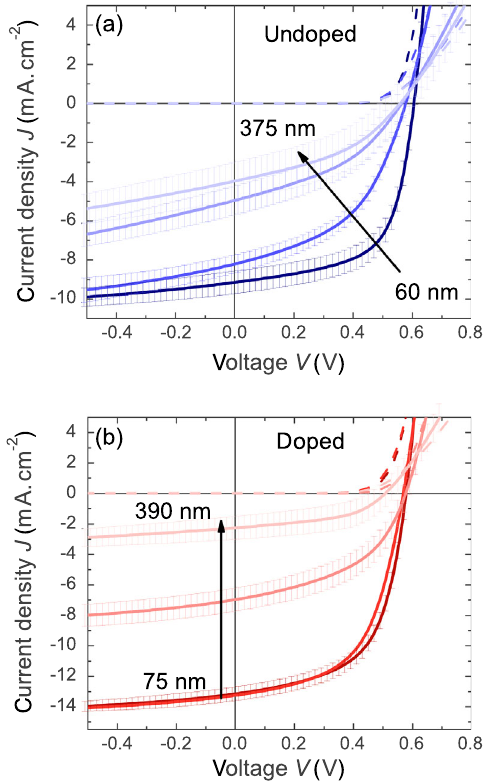
FIG. 3. Experimental AM1.5 (solid lines) and dark (dashed lines) J - V curves at increasing thicknesses for the two batches with different doping levels (a) DPP-TT-T u − PC 71 BM ( N A ≈ 1 . 5 × 10 16 cm − 3 ) at 60-, 160-, 350-, and 375-nm thickness and (b) DPP-TT-T d − PC 71 BM ( N A ≈ 8 × 10 16 cm − 3 ) at 75-, 81-, 160-, and 390-nm thickness. The y -axis error bars corre- spond to the standard deviations measured on at least four